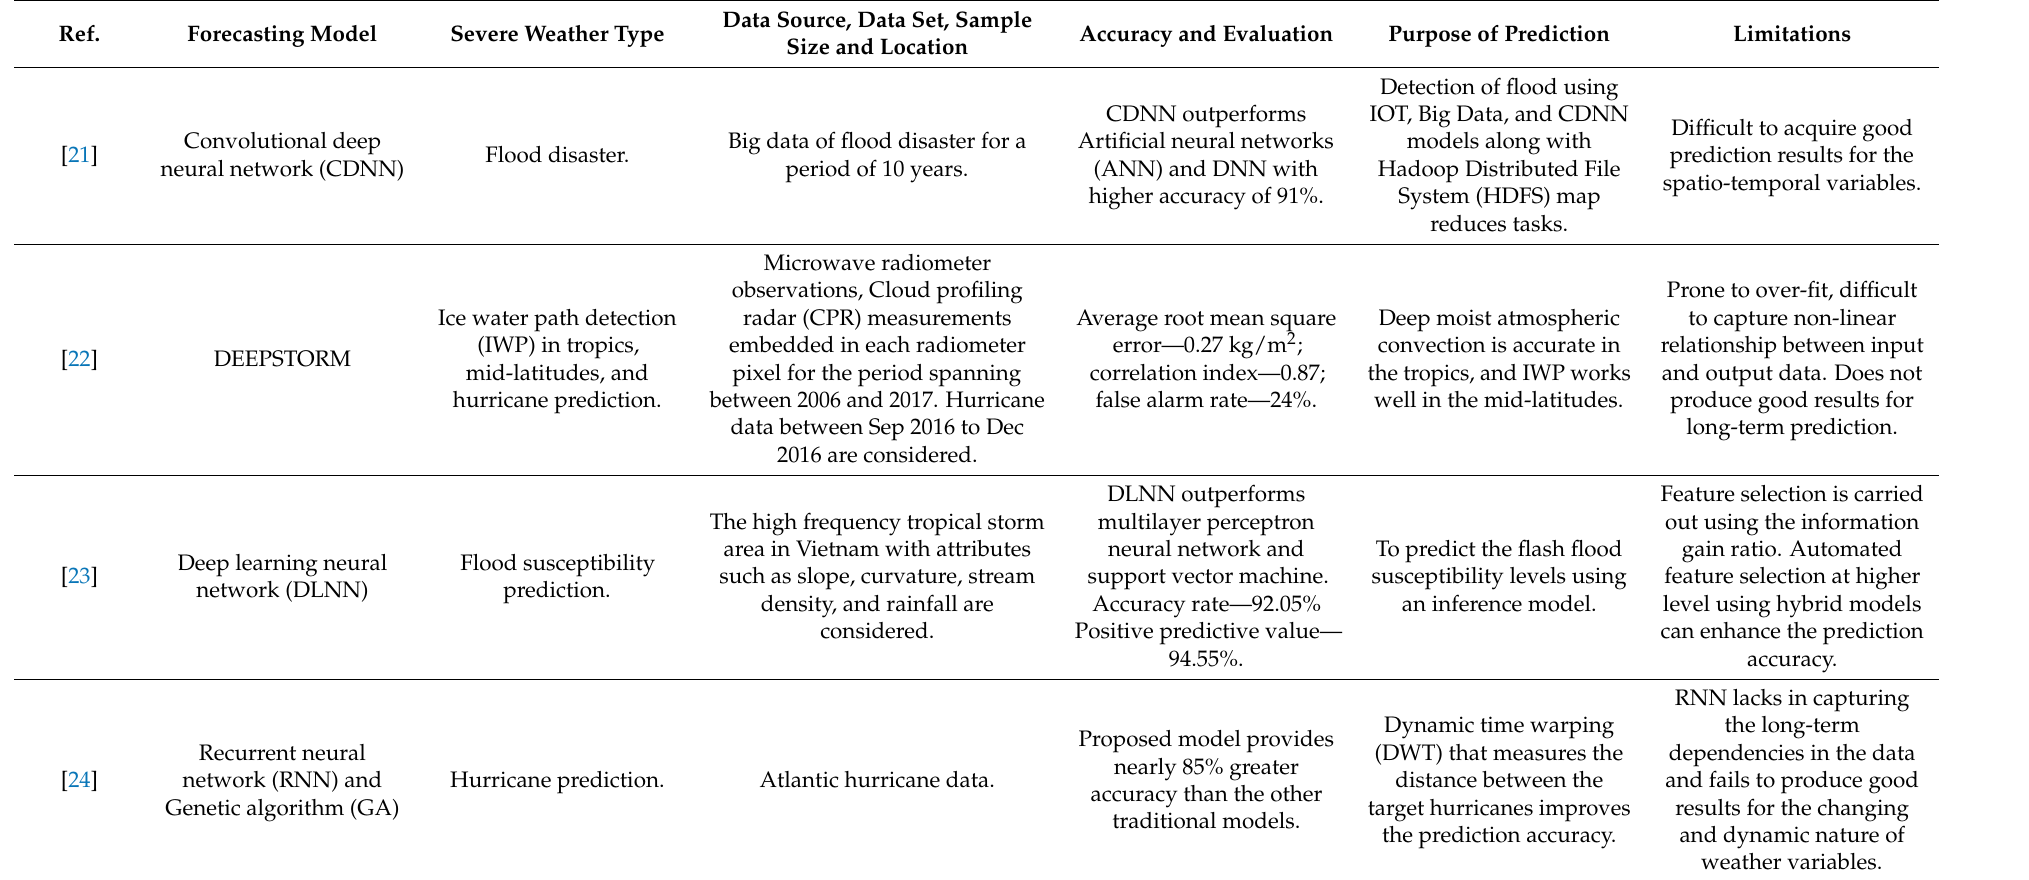
Table 2. Recent studies on extreme weather events prediction using various deep learning